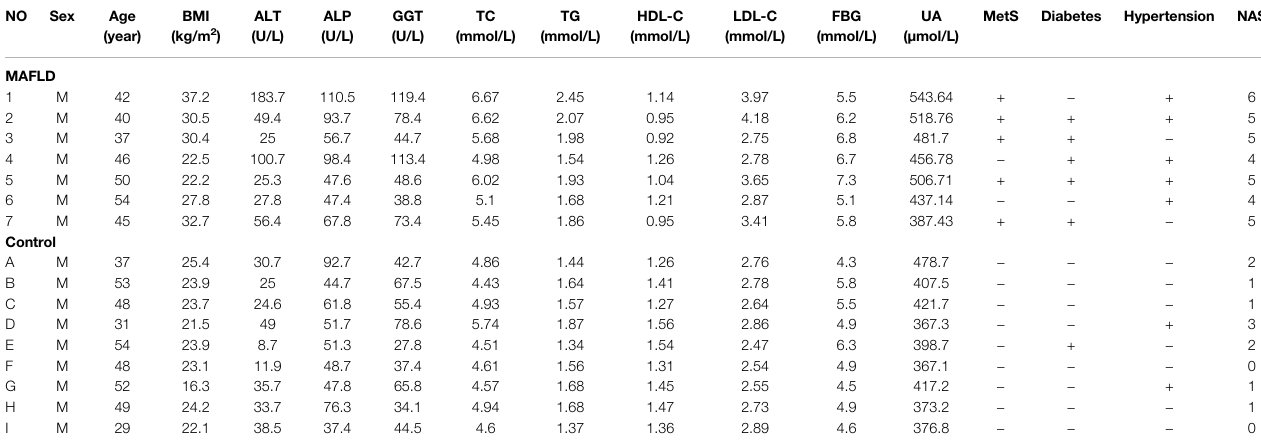
TABLE 1 | Clinical characteristics of MAFLD and control